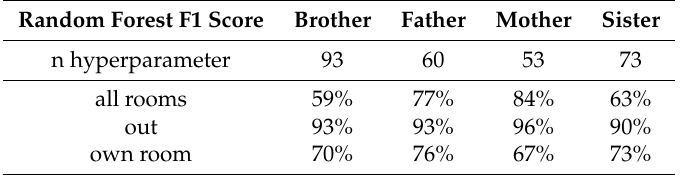
Table 4. Indoor user context information accuracy from the 20 previous events count by room, Random Forest classifier with n hyperparameter